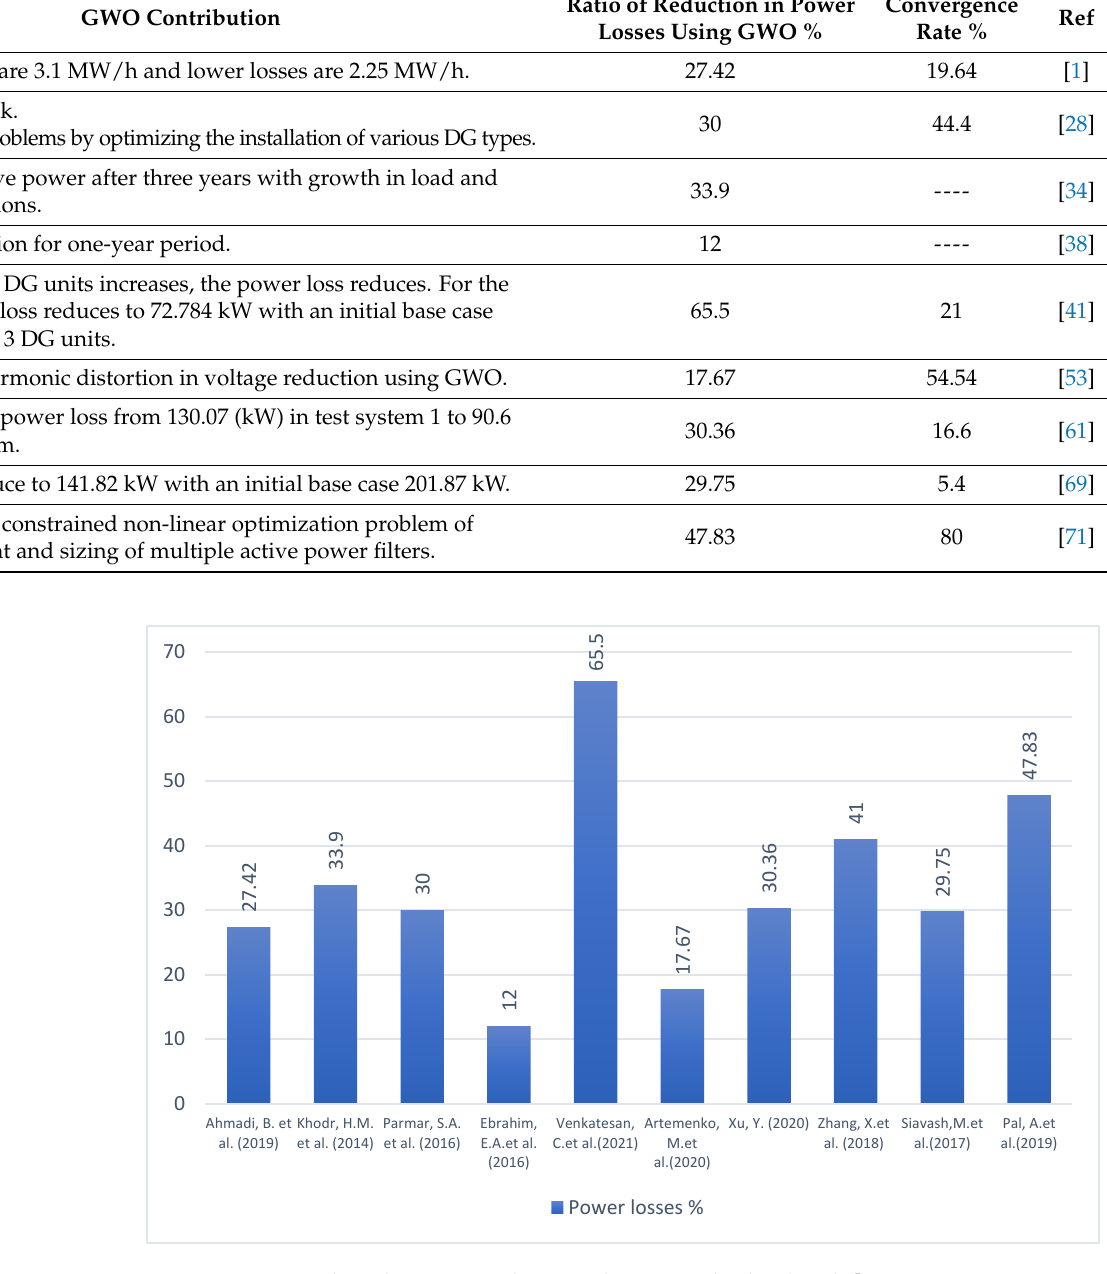
Figure 6. A statistical graph comparing the power losses in each related study